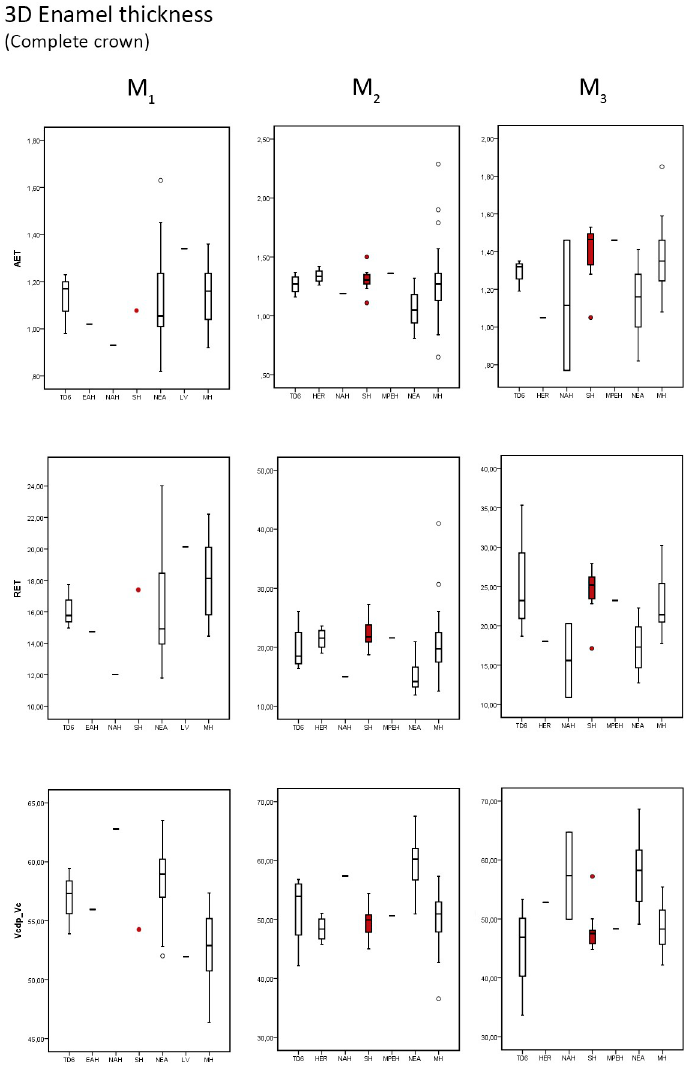
Fig 5. Box plots of the 3D, complete crown, values. 3D values depicting the average enamel thickness (3D AET), relative enamel thickness (3D RET) and the percentage of dentine and pulp in the total crown volume (Vcdp/Vc), in the mandibular molars of the SH and the comparative